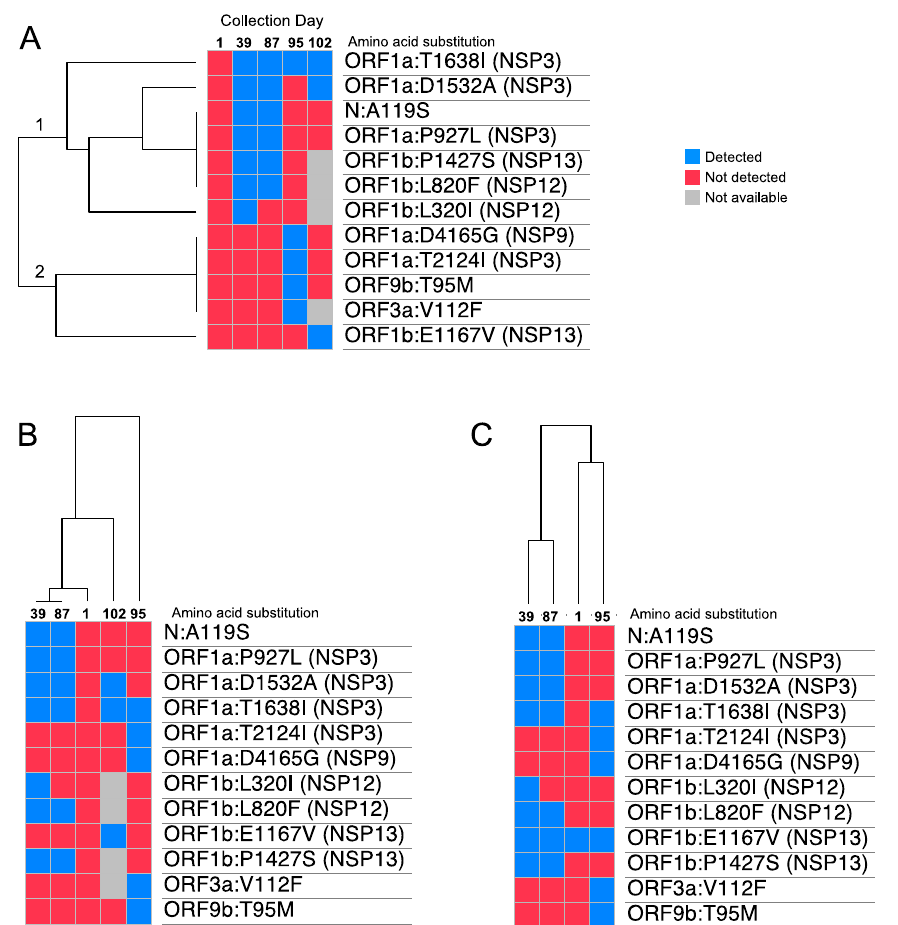
Figure 2. SARS-CoV-2 hierarchical clustering gene expression map. Euclidean distance was used as the distance metric in the hierarchical clustering algorithm. The colored maps show amino acid substitutions with at least one change within days of nasopharyngeal swab collection. Not available means that the region could not be covered during sequencing, so it does not have mutation data. Panel ( A ). Hierarchical clustering was applied over mutations to cluster mutations with similar temporal patterns, and isolates were sorted by collection date. Panel ( B , C ). Hierarchical clustering was applied over collection days to cluster isolates with similar mutation profiles, and mutations were sorted by genomic position. In panel ( C ), day 102 was removed from the clustering since 4 out of 12 mutations corresponded to missing data, which diminishes the clustering confidence.